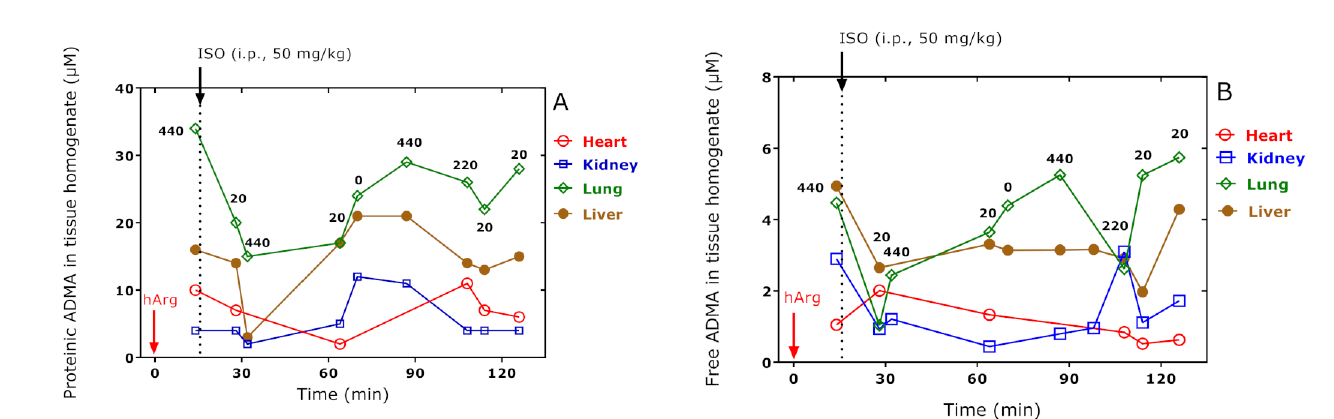
Figure 6. Tissue proteinic ( A ) and tissue-free ( B ) ADMA concentration in organ homogenates of the rats. The indicated hArg doses were administered at t = 0 min and the rats were sacrificed at the indicated time points. Isoprenaline (ISO) was administered at t = 15 min. Arrows indicate the administration of hArg and